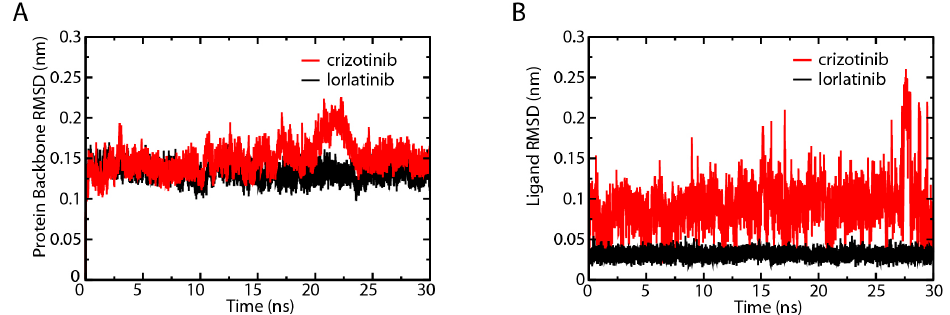
Figure 4. Root-mean-square deviation (RMSD) comparison of the ALK–crizotinib and ALK–lorlatinib complexes Root-mean-square deviationsof the protein backbones ( A ); and ligands ( B ) in ALK– crizotinib and ALK–lorlatinib complexes were calculated and compared.